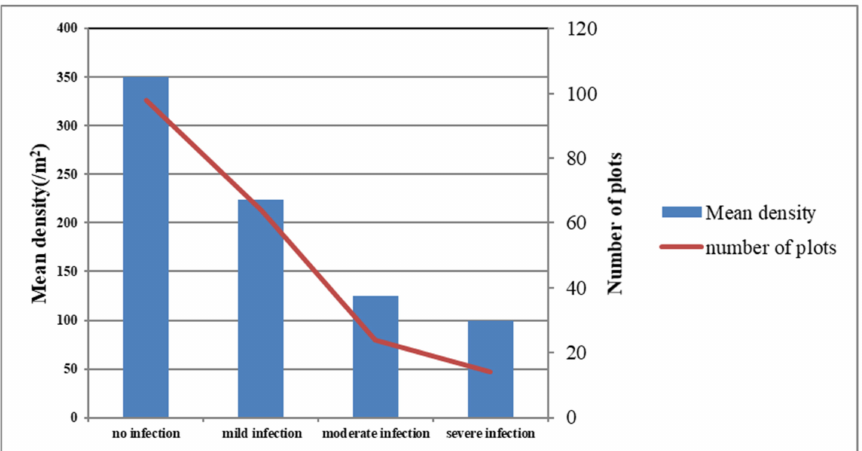
Figure 6. Relationship between the density statistics and the plots. All plots are divided into four groups by disease stress (no infection, mild infection, moderate infection, severe infection).